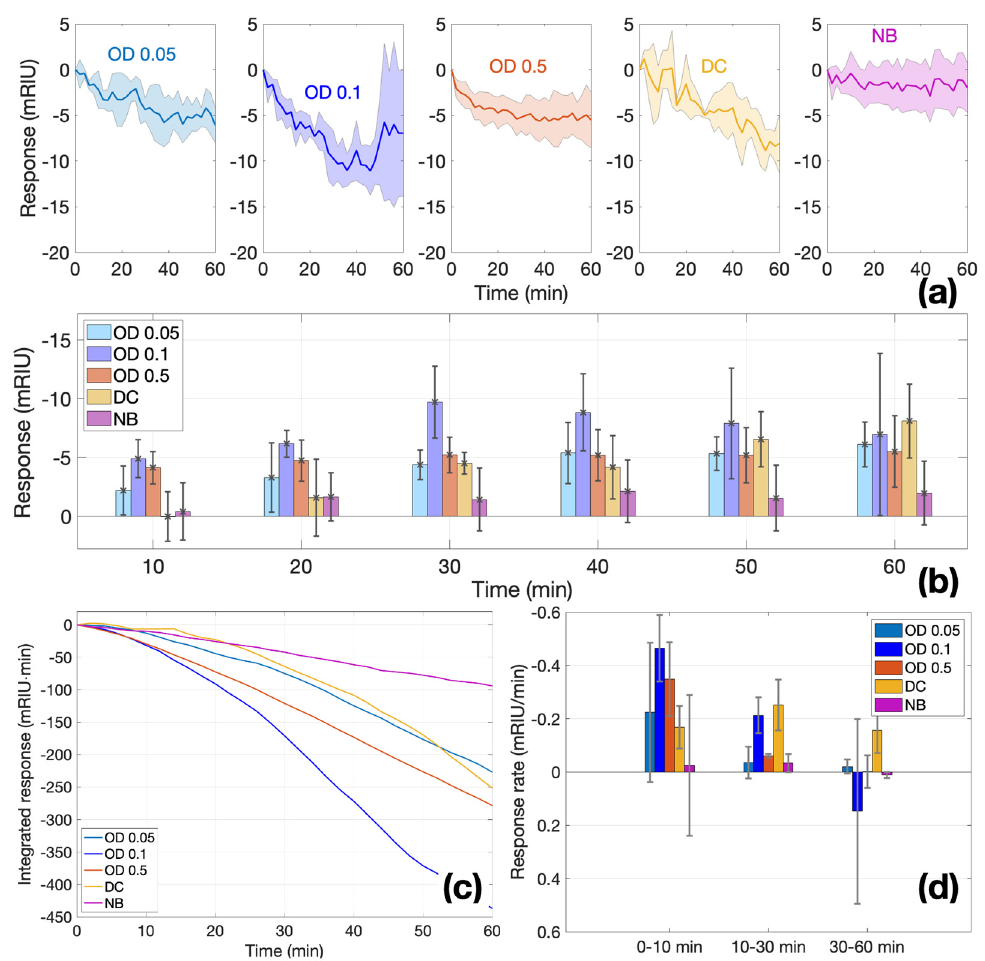
Figure 6. Time response of ball resonators in different bacteria concentrations. ( a ) Normalized response during the 0–60 min time interval for each value of OD (0.05, 0.1, 0.5) and controls (DC, NB); charts report the average (solid line) and ± standard deviation (shadowed region) of 3 different sensors. ( b ) Bar chart reporting the temporal response in each condition, at each time stamp (bar = mean; error bar = ± standard deviation). ( c ) Integrated response, showing the integral of the average response at each time. ( d ) Response rate, estimating the slope of each normalized response over three time intervals (0–10, 10–30, 30–60 min); bar = mean; error bar = ± standard deviation.